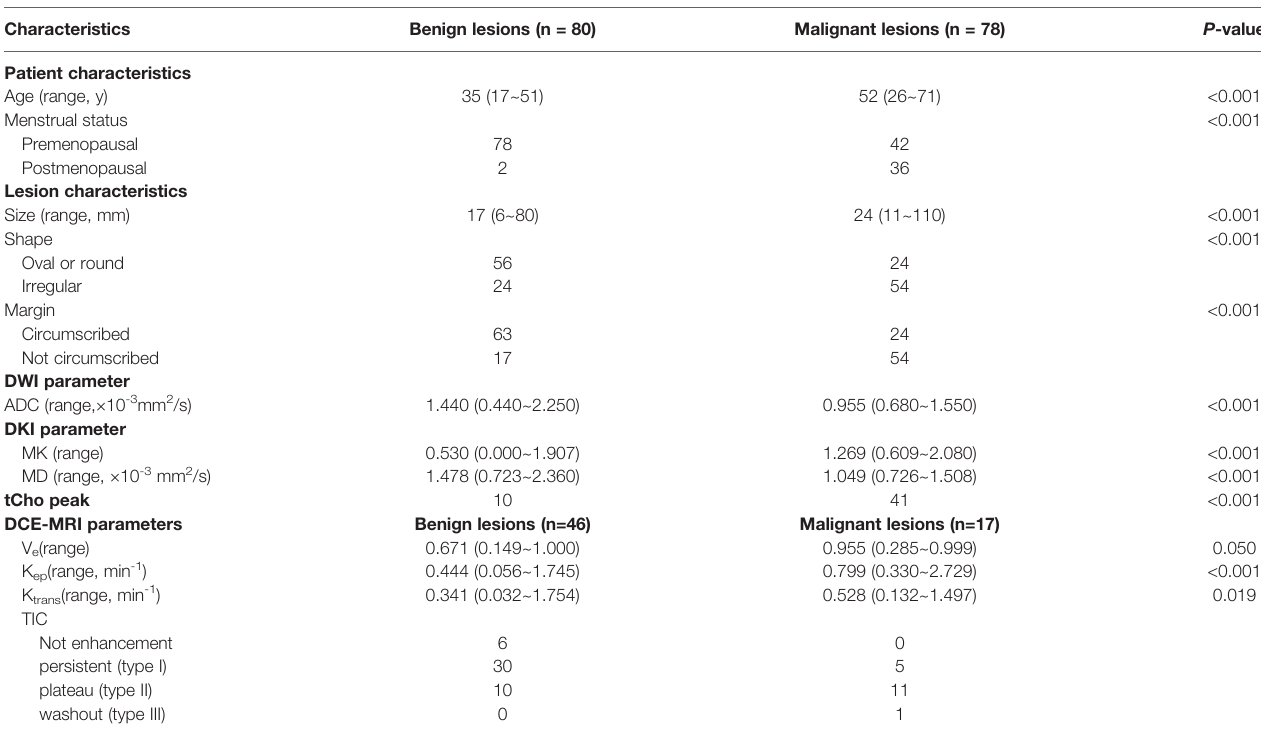
TABLE 2 | The patients ’ clinical and demographic characteristics and tumor features.